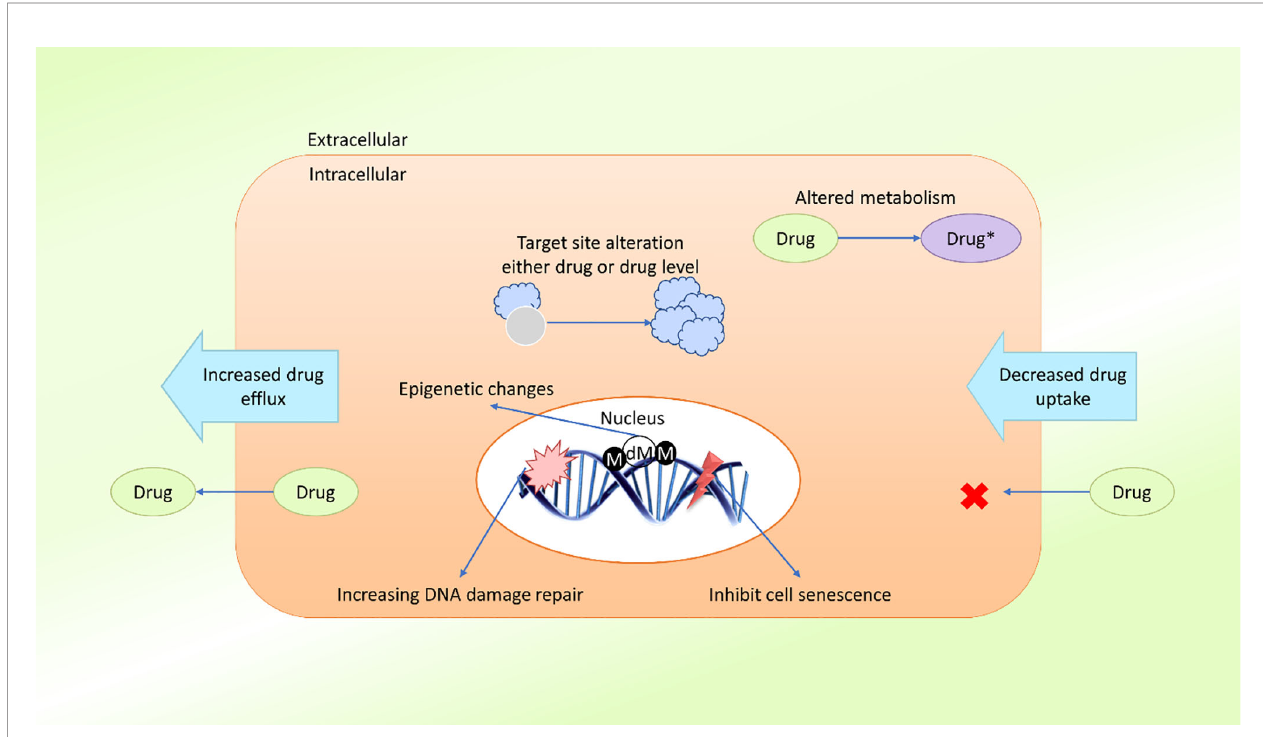
FIGURE 1 | Schematic presentation of possible drug resistance mechanisms in cancer. Cancer cells develop resistance to anticancer agents (drugs) through various mechanisms, such as diminished drug uptake, enhanced drug ef fl ux, improved DNA damage repair, resistance to cellular senescence (apoptosis suppression), alteration of drug metabolism, alteration of the drug target, epigenetic changes, and target gene ampli fi cation. These mechanisms act either individually or in combination, leading to the development of single or multidrug resistance in cancer cells (M, methylation; dM,